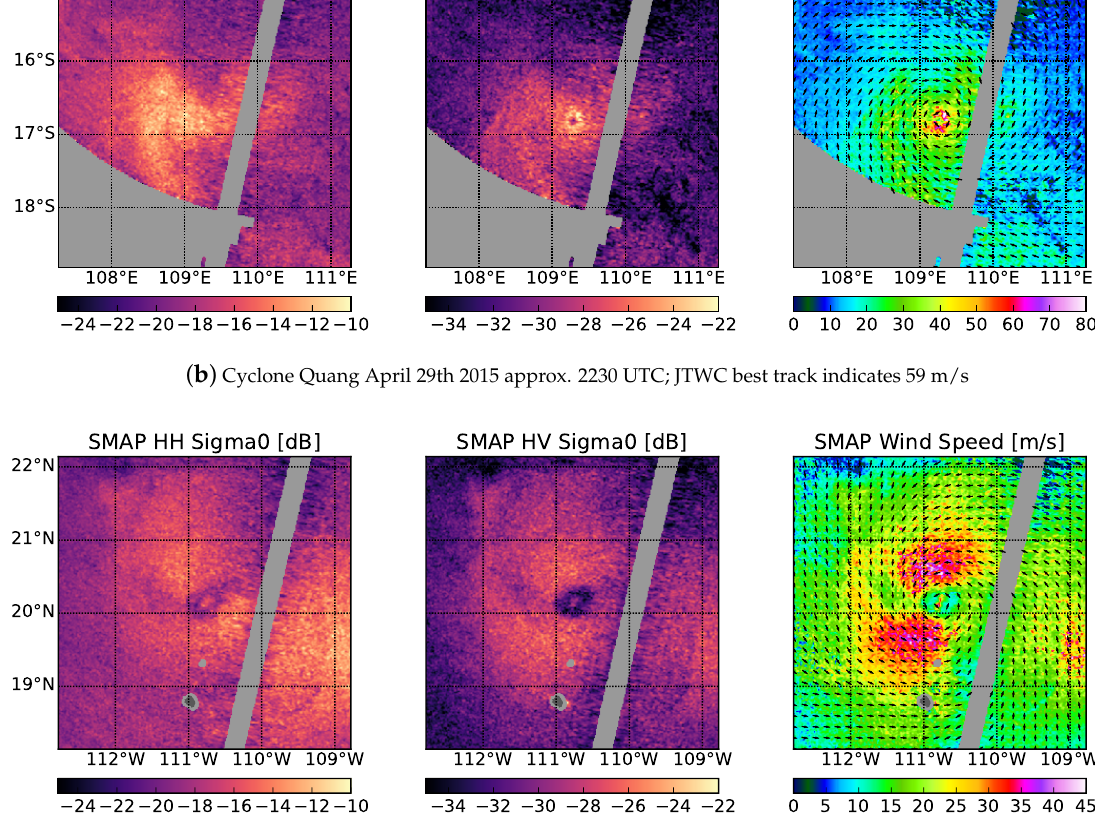
( c ) Hurricane Blanca June 7th 2015 approx. 1340 UTC; NHC best track indicates 44 m/s Figure 2. ( a ) Typhoon Noul, ( b ) cyclone Quang, ( c ) hurricane Blanca. In each we have (left) HH σ 0 , (middle) HV σ 0 , (right) SAR wind speed. The arrows on the right plots are cyclonic prior wind direction used in speed retrieval. The VV σ 0 is not shown, however, it is qualitatively very similar to the HH σ 0 . In each we can clearly see the eye-wall in the HV, however, only in the case of Blanca is the eye-wall clearly visible in the HH σ 0 . There is a distinctive hour-glass shape in each of the HH images due to the high directional modulation for co-polarizations while the HV does not show this